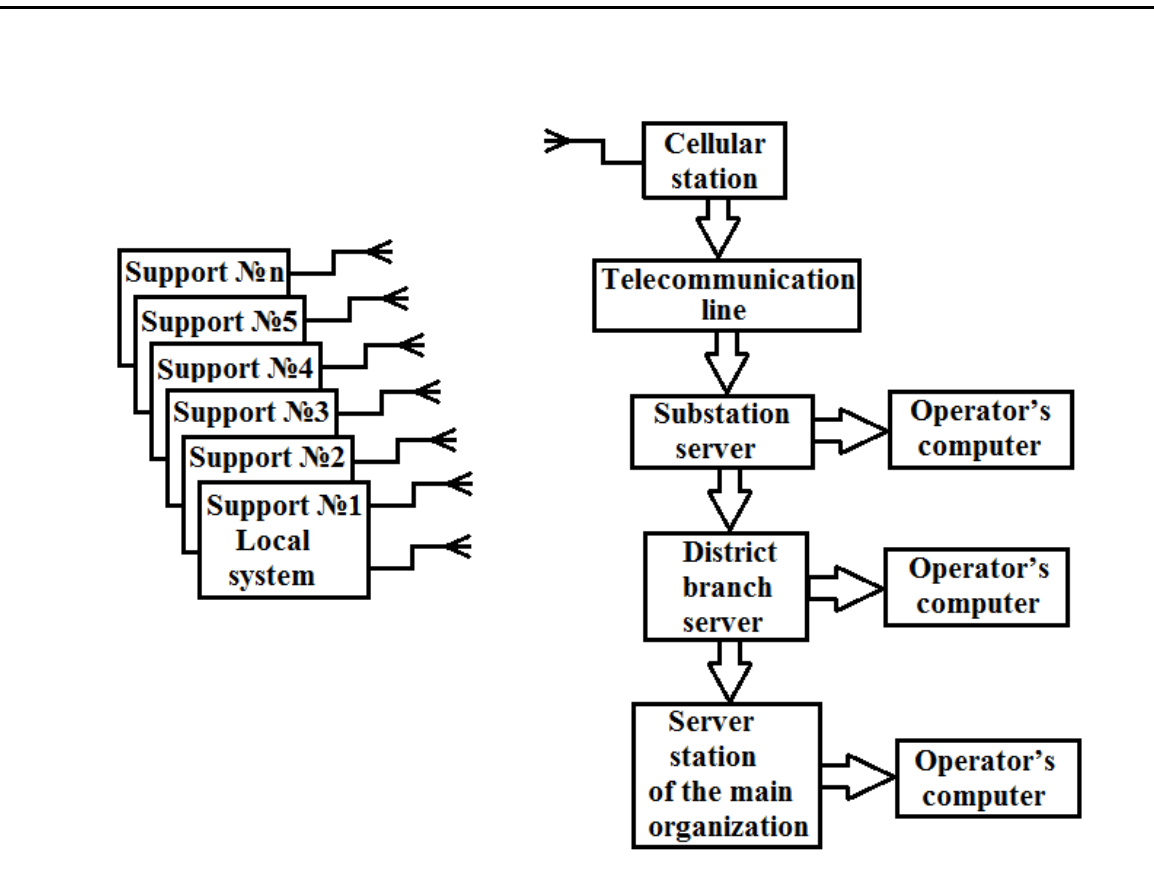
Figure 1. Functional system